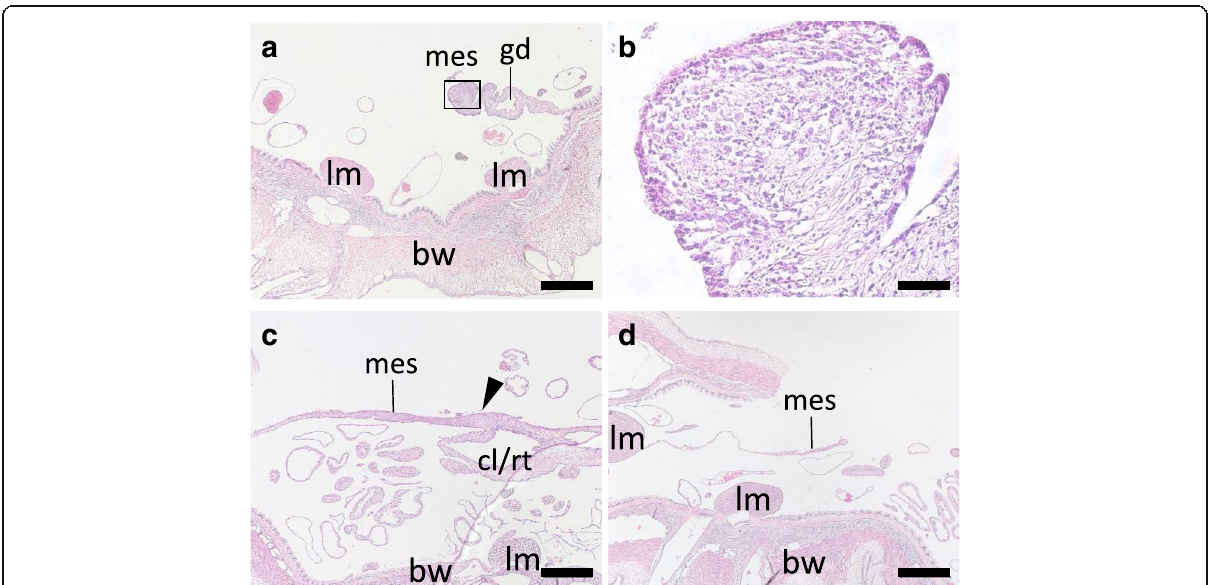
Fig. 6 Histology of the tissues at stage II. Cross sections of the body at stage II (4 dpe) were stained with HE, focusing on the mesentery at the anterior ( a , b ) and posterior ( c , d ) regions of the body. a , b Anterior mesentery. A mass of cells is present on the free edge of the mesentery. b is a high-magnification view of the boxed area in a . c Posterior tissue. A thickening of tissue (arrowhead) is observed at the connection of the mesentery and the cloaca. Respiratory trees are an organ continuous from the cloaca, and thus these two tissues could not be strictly distinguished. d Posterior tissue, anterior than c . A part of the mesentery with a free edge is shown. bw, body wall; cl/rt., cloaca or respiratory trees; gd, gonadal duct; lm, longitudinal muscle; mes, mesentery. Scale bars 500 μ m in a , c , d ; 50 μ m in